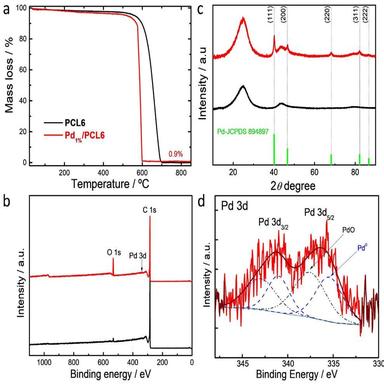
(a, b) Cyclic voltammograms obtained in N2 and O2-sat 0.1 mol L1 K2SO4 at pH 2.5 for GC electrodes modified with PCL6 and Pd1%/PCL6 (scan rate: 50 mV s1 ; scans started at 1.0 VAg/AgCl). (c) Linear sweep voltammetry in an RRDE configuration scanning the potential at 5 mV s1 and 900 rpm in O2-sat 0.1 mol L1 K2SO4 at pH 2.5 (scans started at 0.9 or 0.2 VAg/AgCl). (d) SH2O2 during the ORR at varying potentials (obtained from the corresponding RRDE data). (e, f) Linear sweep RDE results scanning the potential a